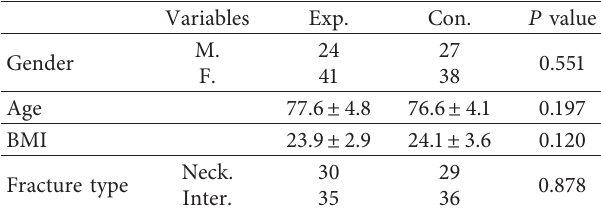
Table 1: Baseline characteristics of patients in the two